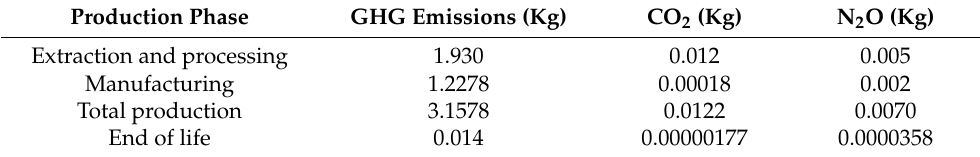
Table A2. Average vehicles emissions per